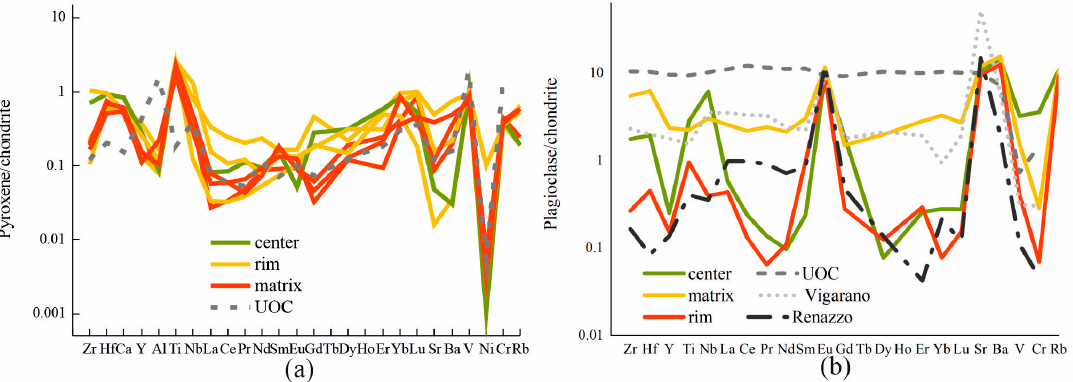
Figure 10. CI chondrite-normalized trace element patterns of low-Ca pyroxene ( a ) and plagio- clase( b ) from chondrules and the Kargapole meteorite matrix.